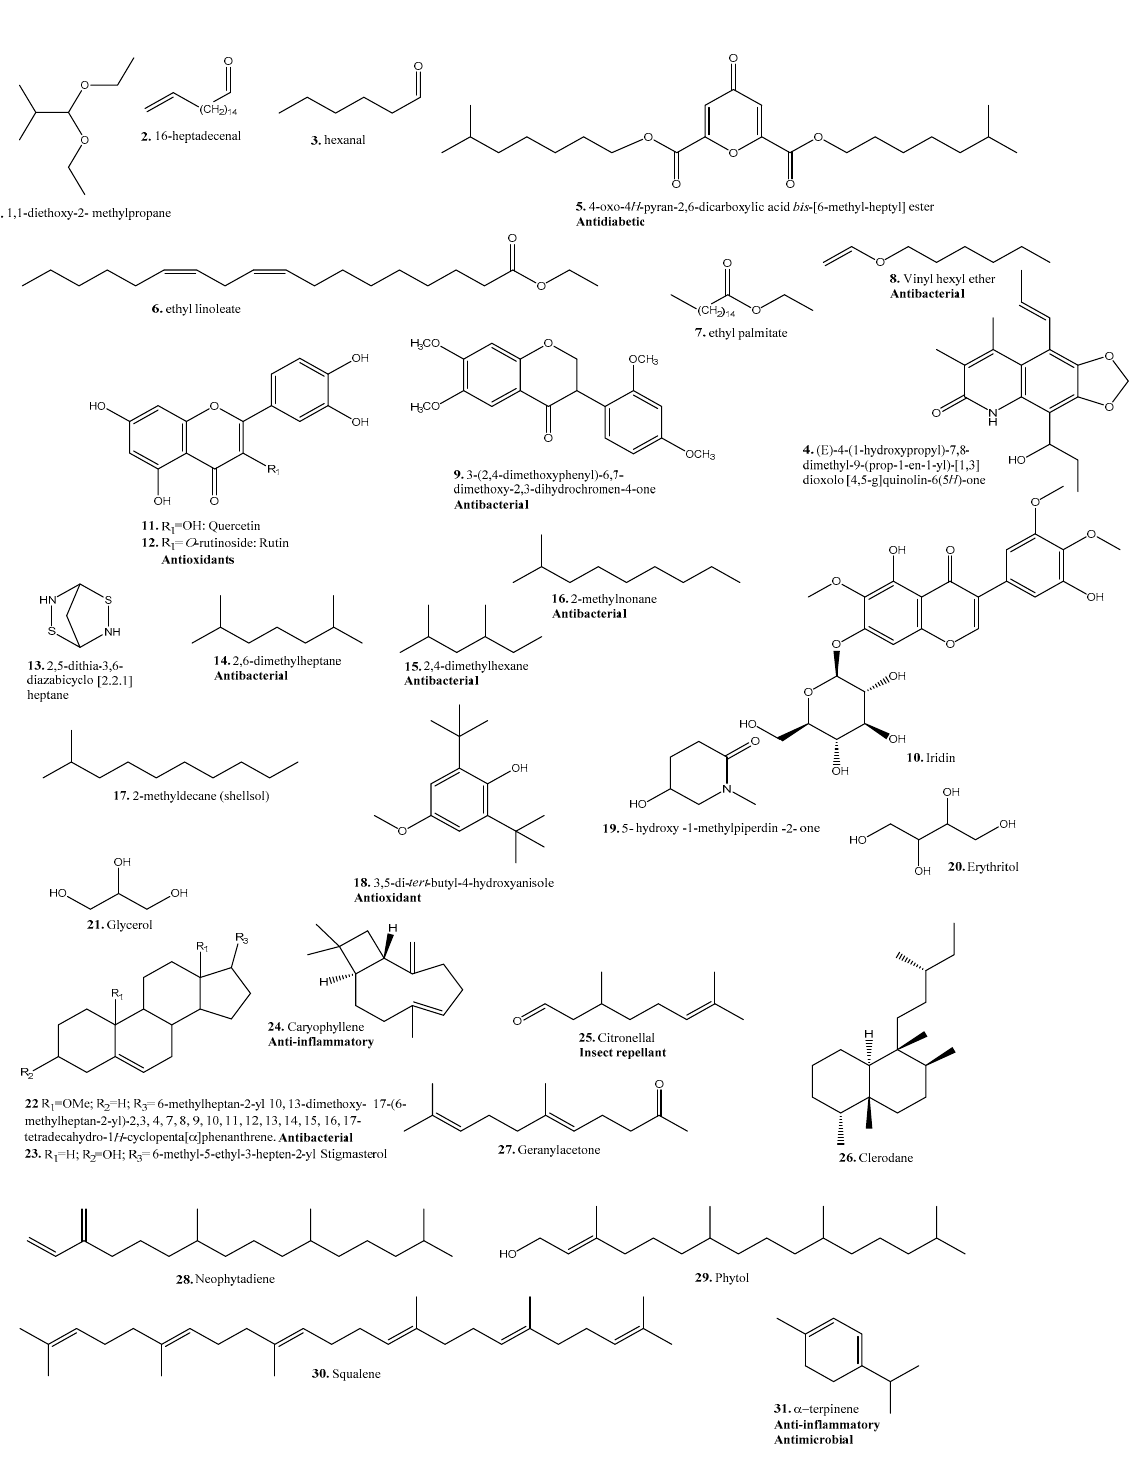
Figure 7. Compounds identified in Tragia extracts and oils.